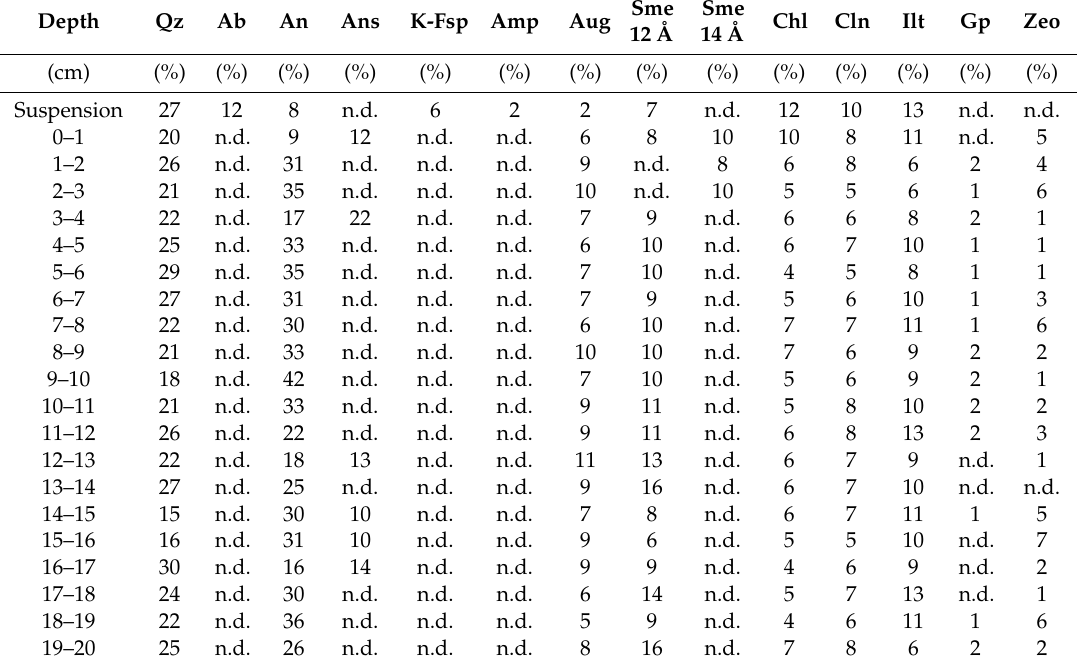
Table 3. Mineral composition of near-bottom suspended matter (suspension) and sediments in the AMK-5454 core, of the Cambridge Strait, the Franz Josef Land Archipelago.